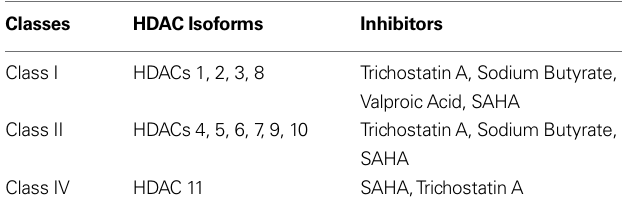
Table 1 | Classical HDAC isoforms and some examples of their targeted HDAC